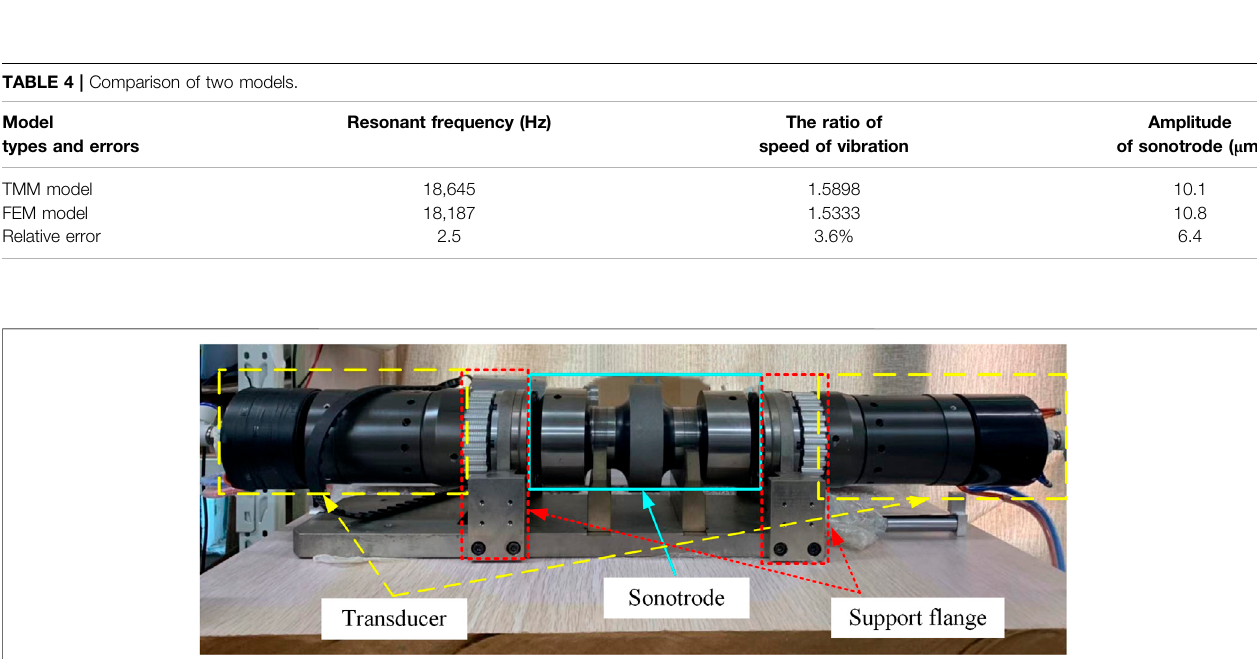
FIGURE 13 | The prototype of sonotrode system.